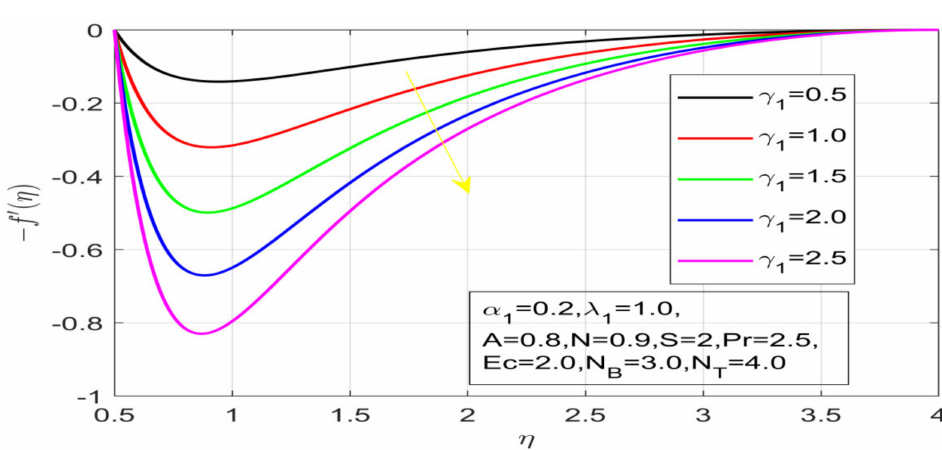
Figure 4. Influence of γ _1 on the velocity